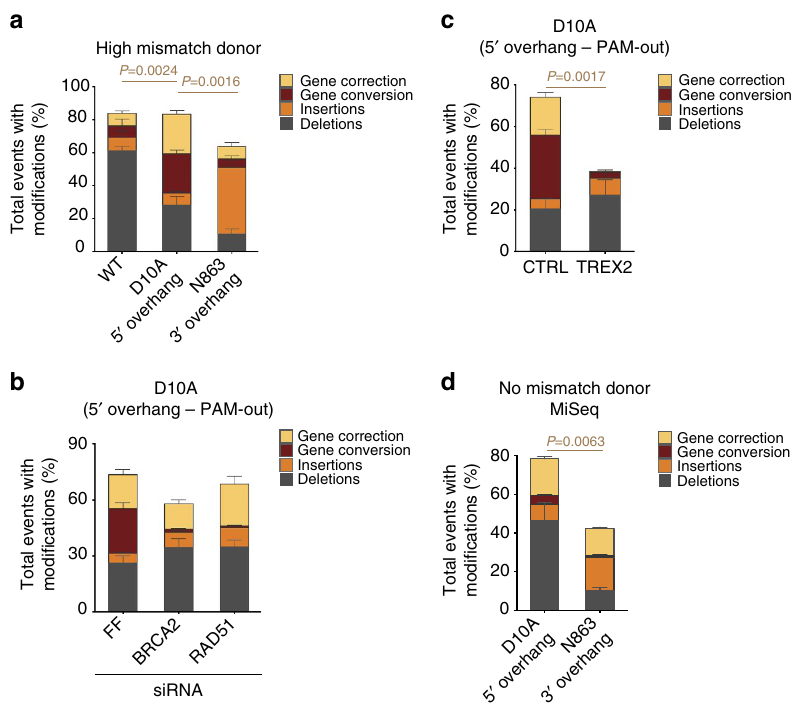
Figure 5 | Characterization of gene correction using an ssODN. ( a ) Overall modification frequency at the HBB locus resolved for deletions, insertions, gene conversion (GC), and gene correction. The different repair outcomes after WT, D10A or N863A Cas9 activity in the presence of the ‘high mismatch donor’ in U2OS cells were measured by Sanger sequencing of individual HBB amplification products. Data are represented as mean ± s.e.m. The P values (gene correction) were calculated using the two-tailed Student’s t -test. Total number of sequences plotted from three independent experiments: 200 for WT Cas9, 448 for D10A Cas9, and 422 for N863A Cas9. ( b ) Characterization of genetic requirements of gene correction. U2OS cells